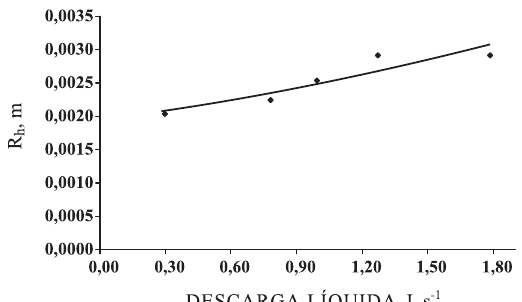
Figura 5. Relação entre a descarga líquida e o raio hidráulico na erosão em sulcos. Média de cinco